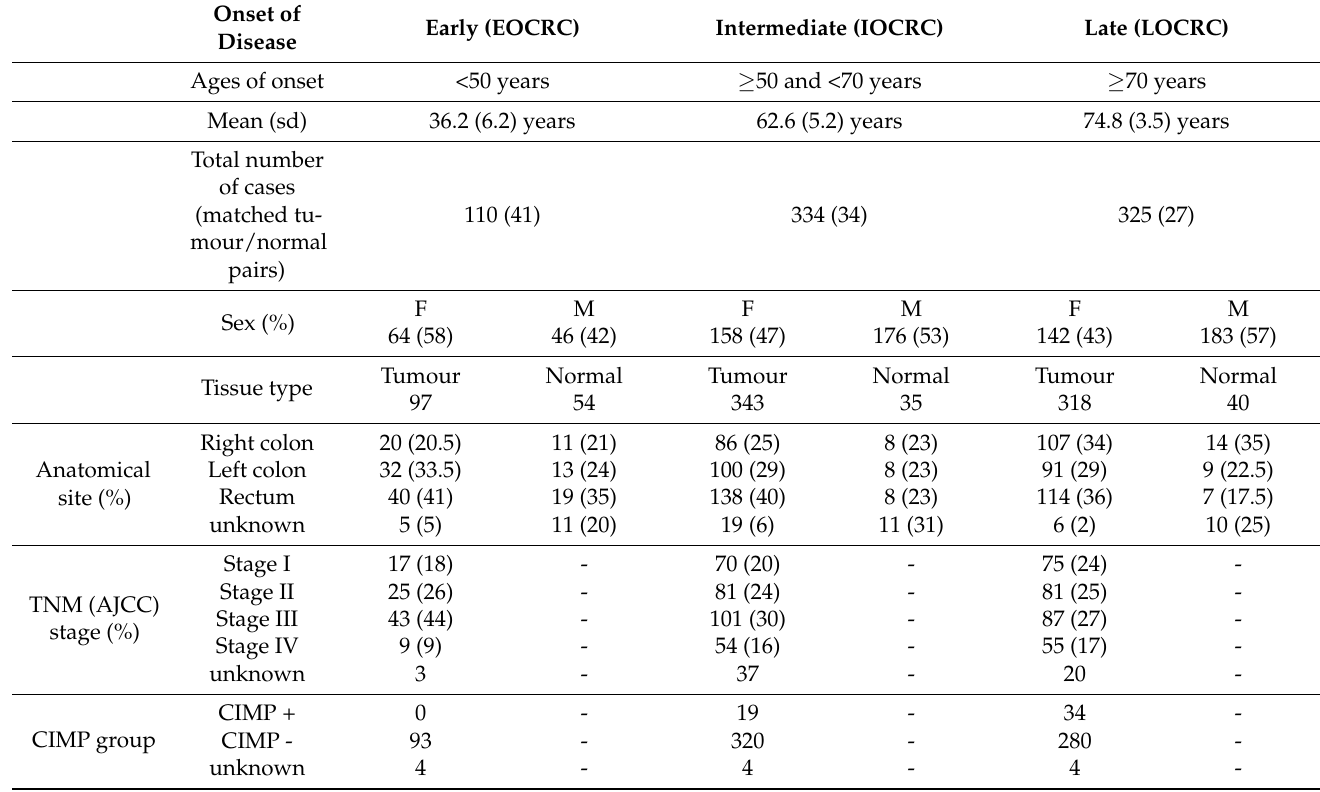
Table 1. CRC-affected participant and tumour characteristics for early, intermediate, and late-onset groups.